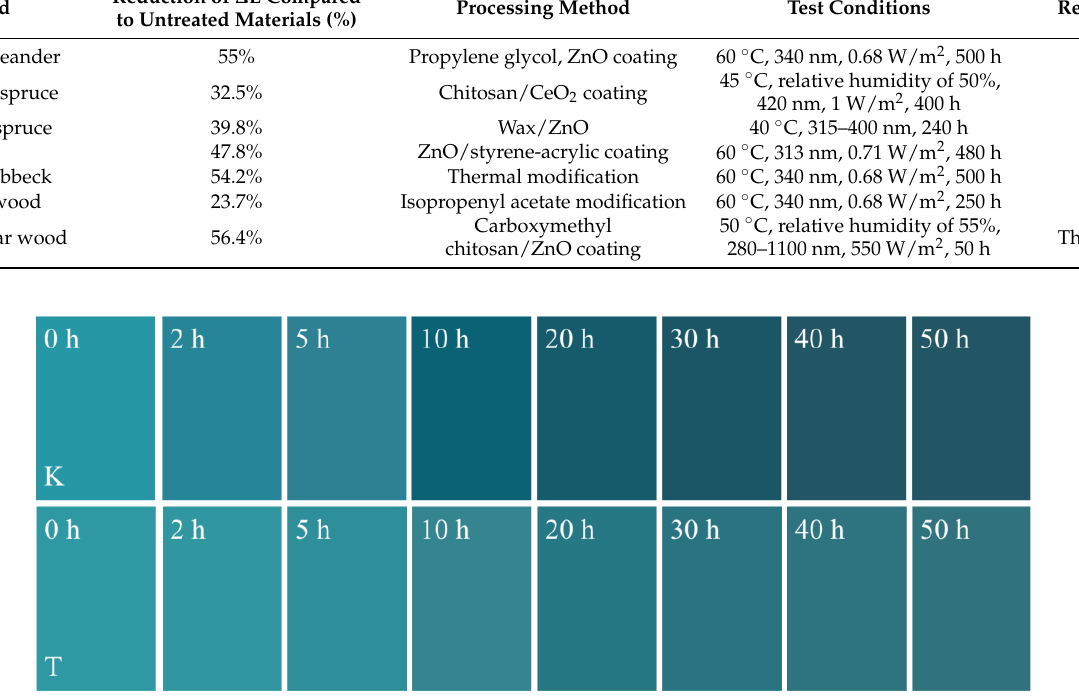
Figure 5. Visual assessment of the untreated dyed wood (K) and treated wood (T) after 50 h UV